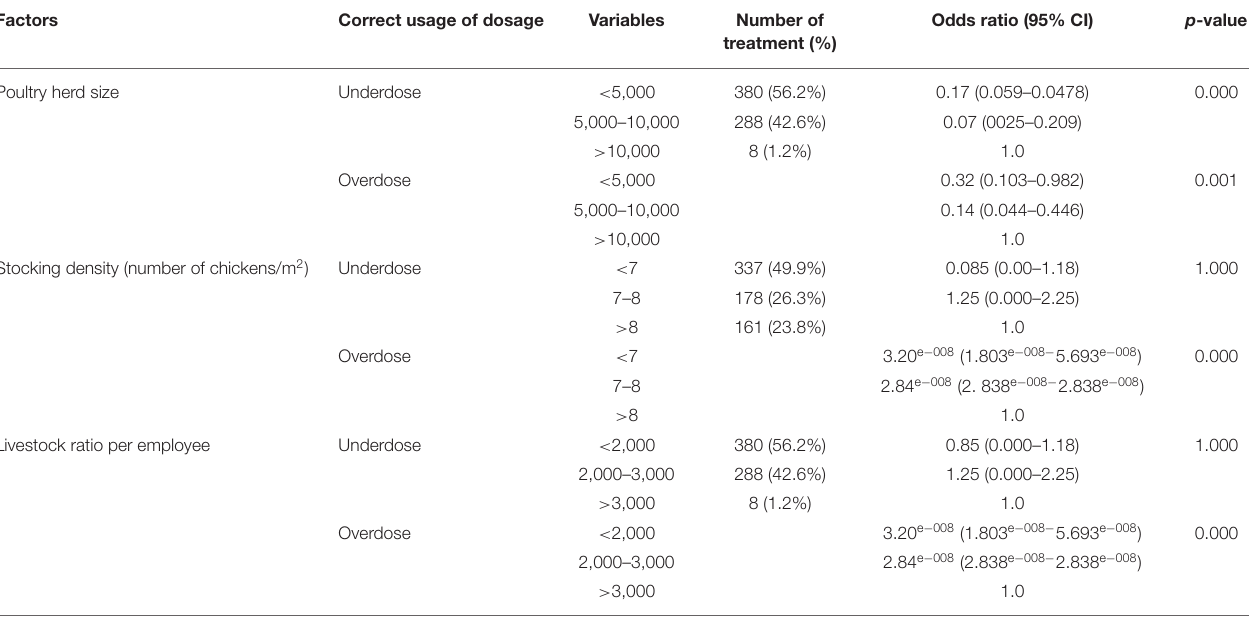
TABLE 6 | Factors that affected the correct usage of antimicrobials in layer farms in the West Region of Cameroon.